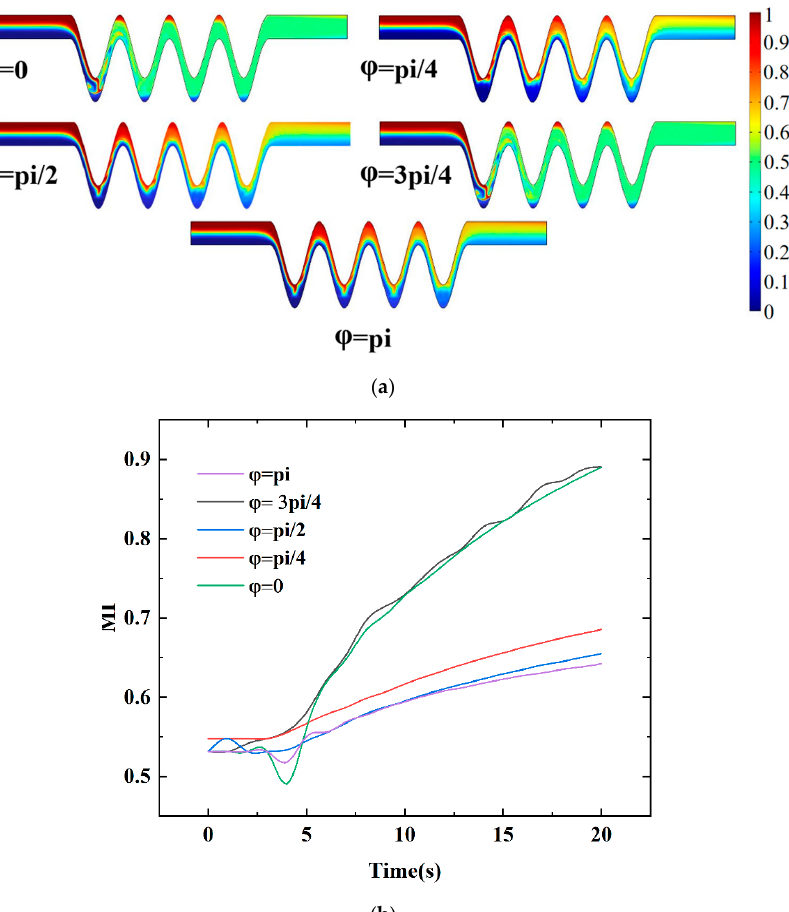
Figure 13. The effect of phase shift: ( a ) distributions of concentration surface along the micromixer for different phase shifts, ( b ) the mixing index at the outlet for different phase shifts within 0–20 s when four pairs of electrodes, U 0 = 0.1 mm/s, V 0 = 2 V, and f = 5 Hz .